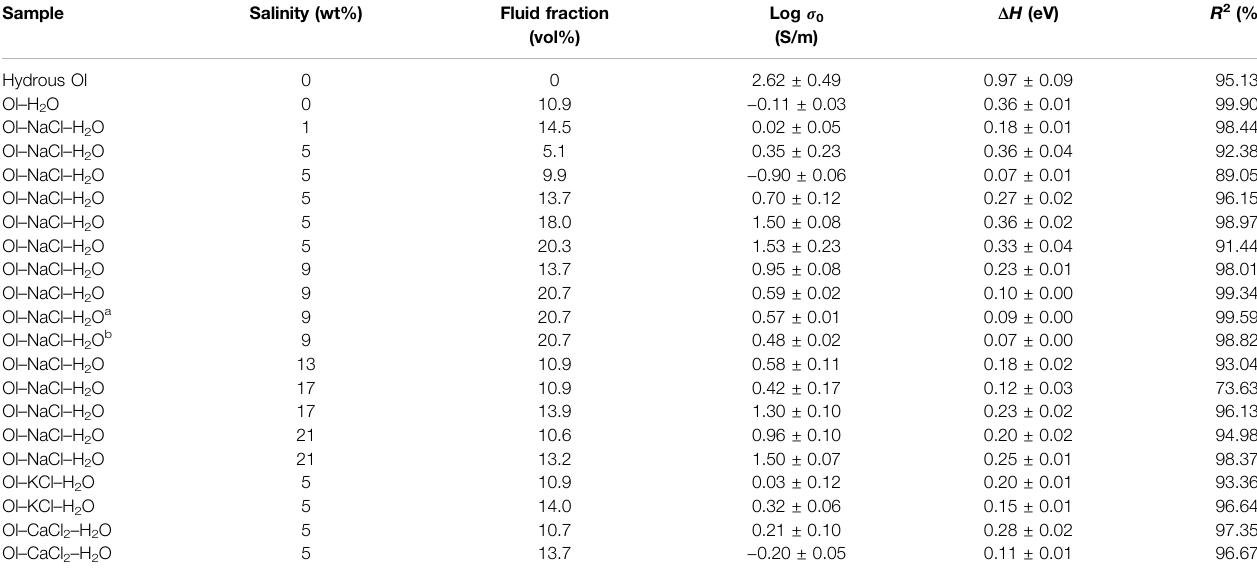
TABLE 1 | Thermodynamic parameters for the electrical conductivities of hydrous olivine aggregates, the Ol – H 2 O system, and saline fl uid-bearing olivine aggregates with various salinities and fl uid fractions at 2.0 GPa and 773 – 1073 K, except for runs a and b, which were conducted at 2.5 and 3.0 GPa, respectively. Sample Salinity (wt%) Fluid fraction (vol%) Hydrous